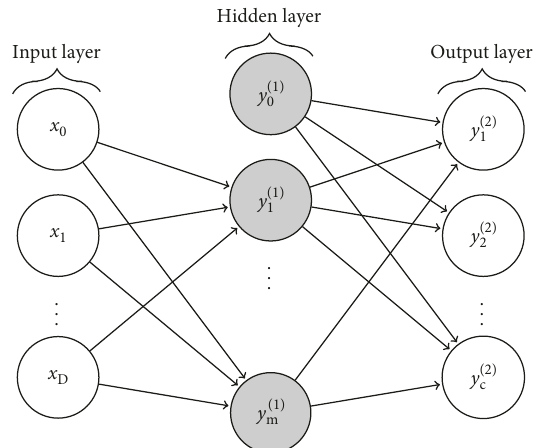
Figure 1: Example of MLP. Image adapted from Stutz